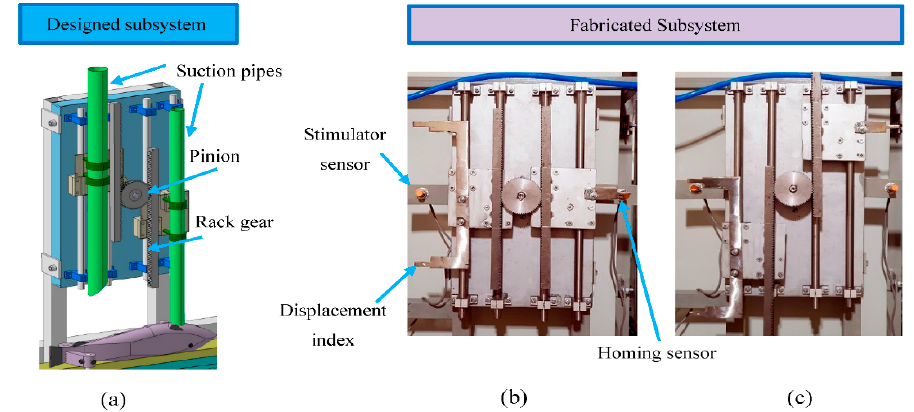
Figure 8. Gutting subsystem: ( a ) designed subsystem, ( b ) homing position with the applied sensor in the right side, and ( c ) functioning position with the limit sensors in the left side of the subsystem.